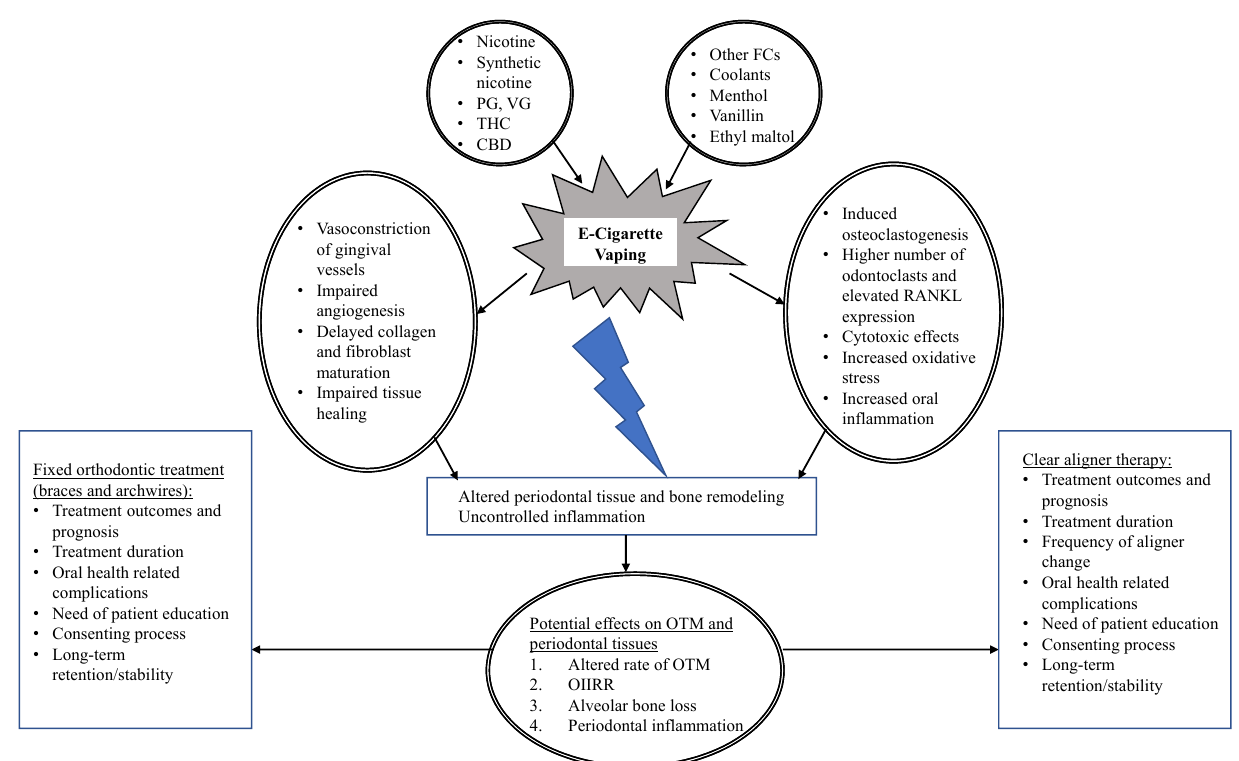
Figure 1. E-cigarette vaping as a risk factor for potential complications during orthodontically- induced tooth movement. Possible biological mechanisms and clinical considerations. Abbreviations: VG, vegetable glycerin; PG, propylene glycol; CBD, cannabidiol; THC, tetrahydrocannabinol; FC, flavoring chemicals; RANKL, receptor activator of nuclear factor kappa-B ligand, OTM, orthodontic tooth movement; OIIRR, orthodontically-induced inflammatory root